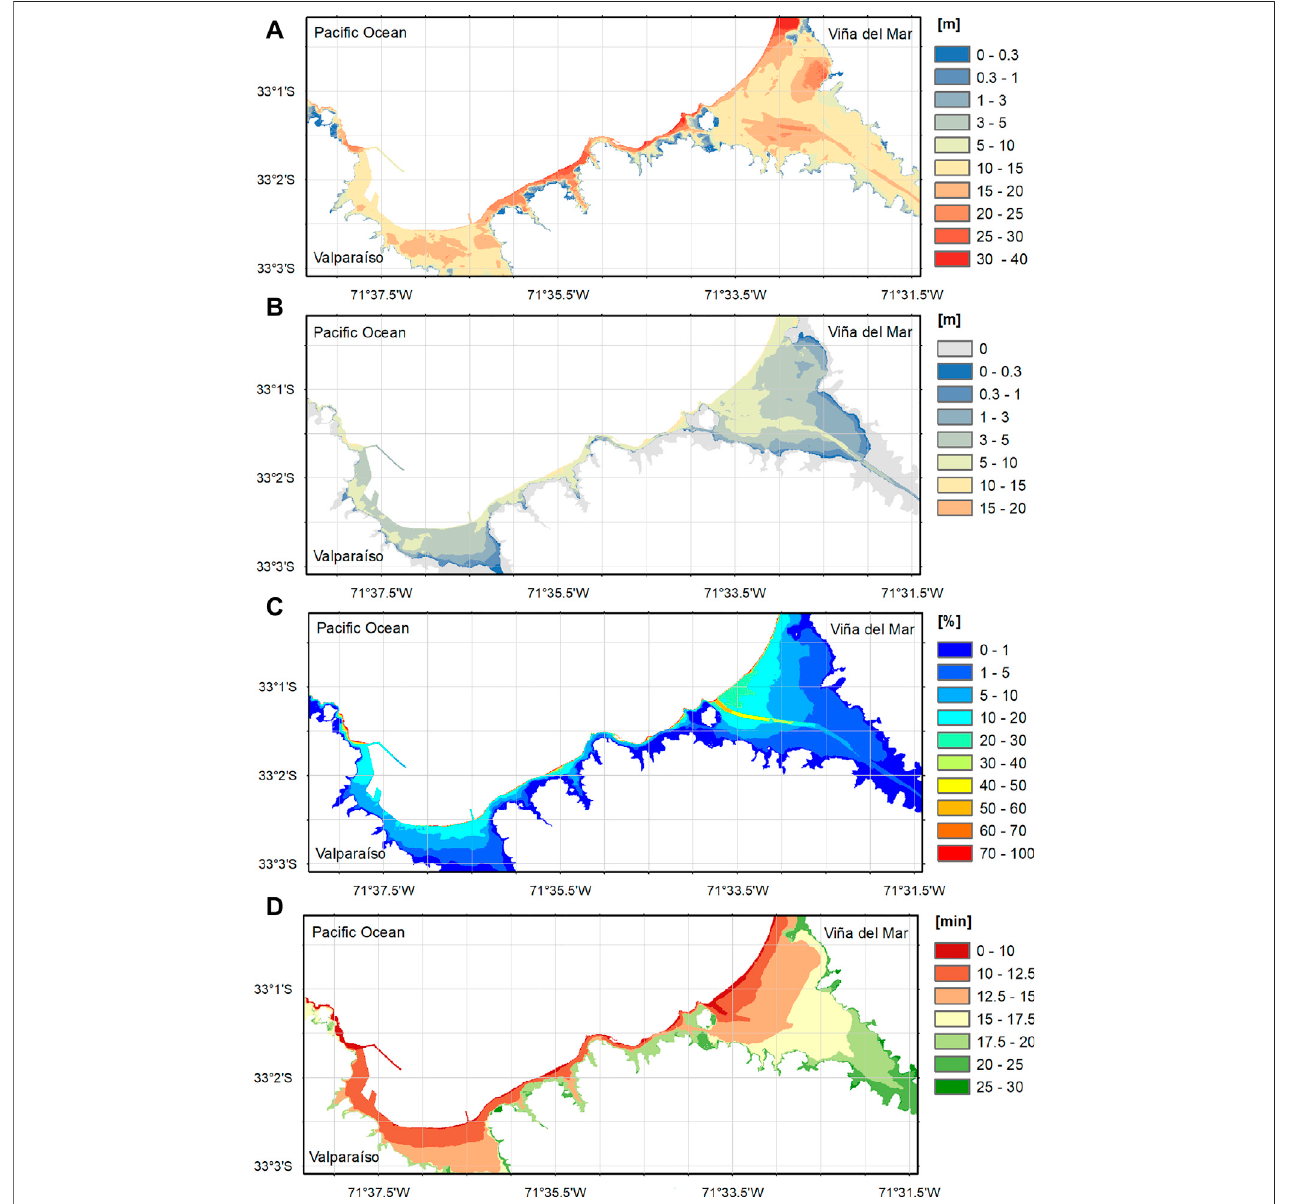
FIGURE 5| Maps ofinundation statistics at Valparaíso and Viña del Mar: integration of all scenariosbetween M w 8.6 – 9.2 (A) Envelope of the maximum fl ow depth d m ( x , y ) (B) P d of the maximum fl ow depth of the set of scenarios (C) Fraction of events that inundate each cell; and (D) Minimum arrival time at each cell, t a ( x , y ) . m , 95% Values of fl ow depth are provided in meters, arrival time in minutes and the fraction in percentage. In the Supplementary Figures S3 – S9 similar maps are shown for each M w